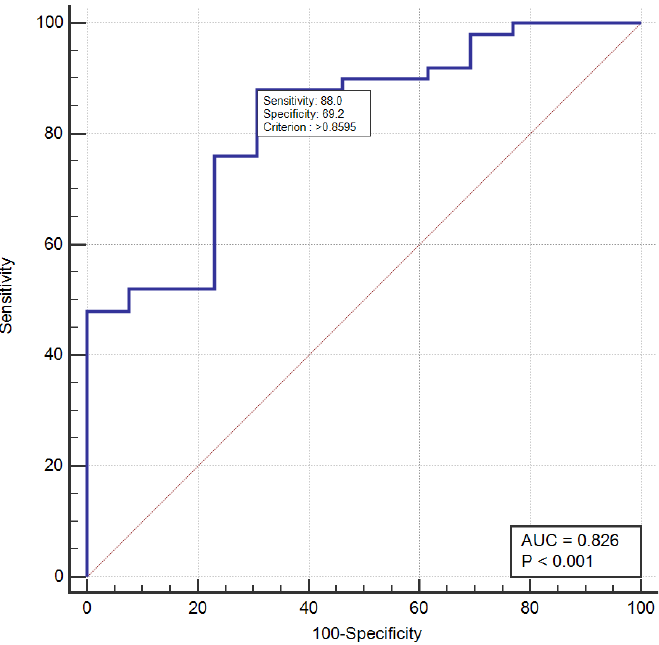
Figure 6. ROC curve for combined model based on T2min relaxometry parameter and N stage, in predicting early treatment response to NAT.